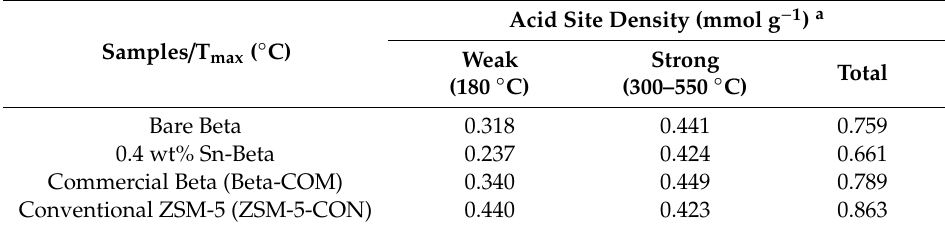
Table 2. Acid sites density of all samples determined via the ammonia temperature-programmed desorption (NH 3